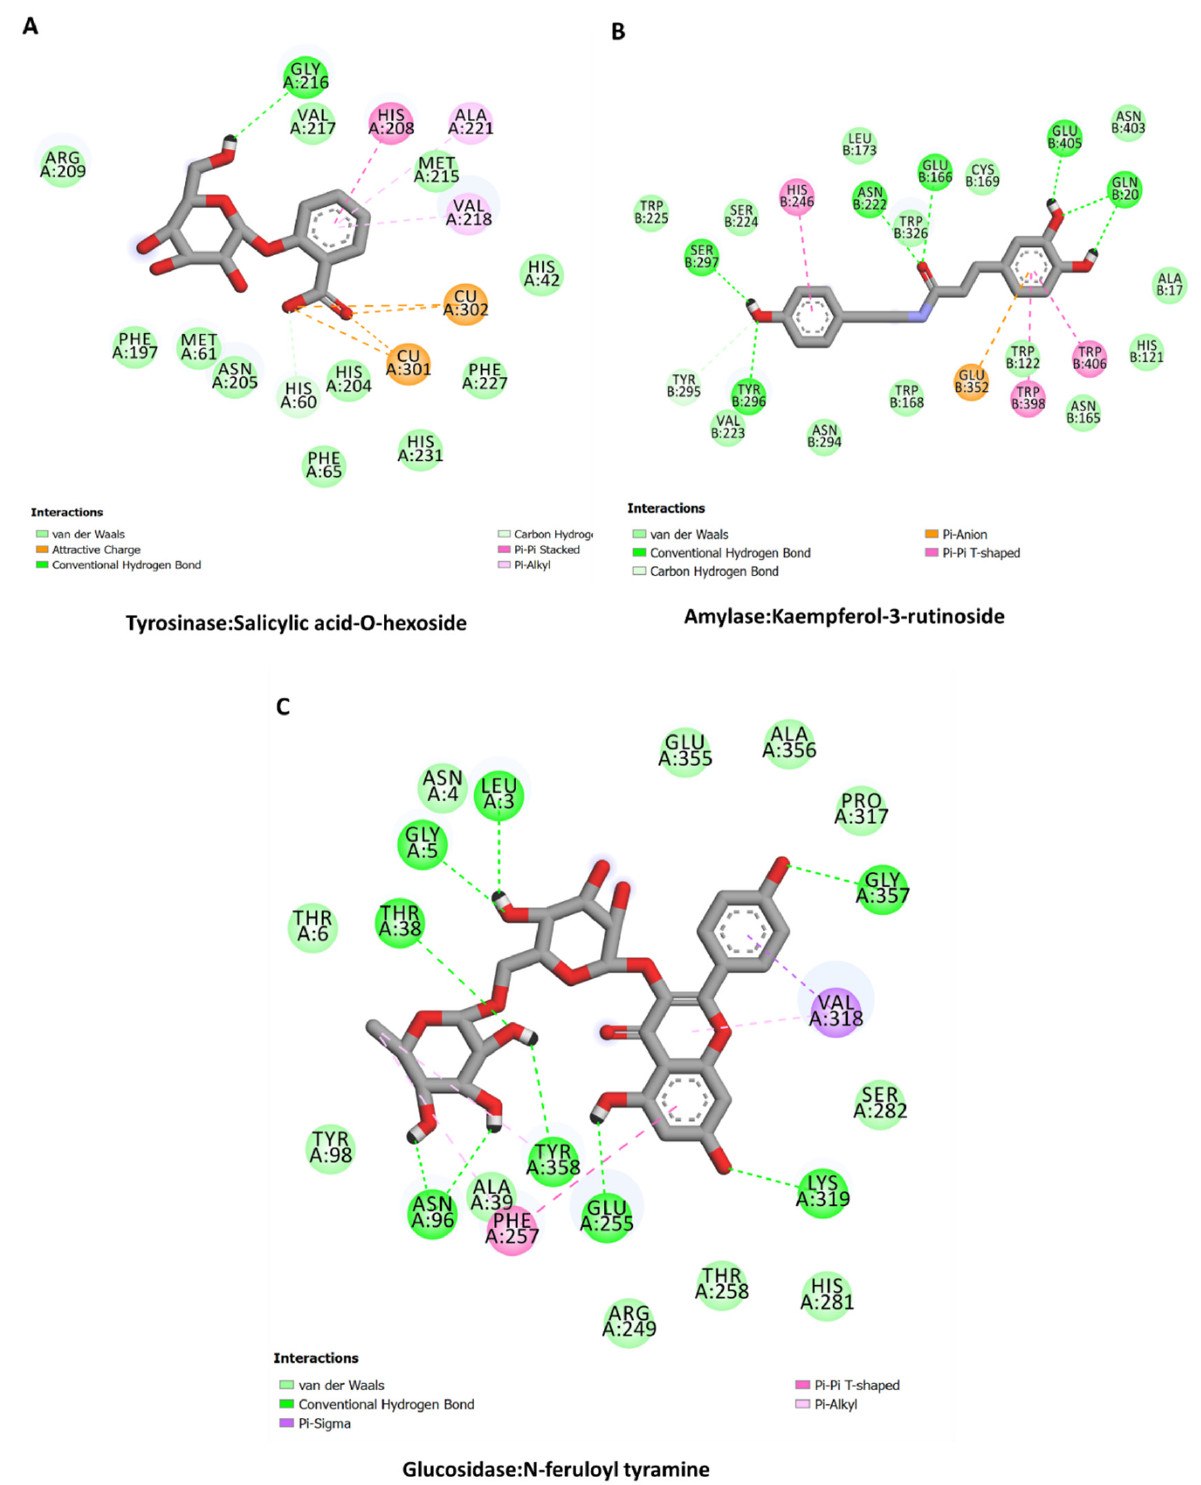
Figure 7. Protein-ligand interactions: ( A ) tyrosinase and salicylic acid-O-hexoside, ( B ) amylase and Kaempferol-3-rutinoside, and ( C ) glucosidase and N-feruloyl tyramine.